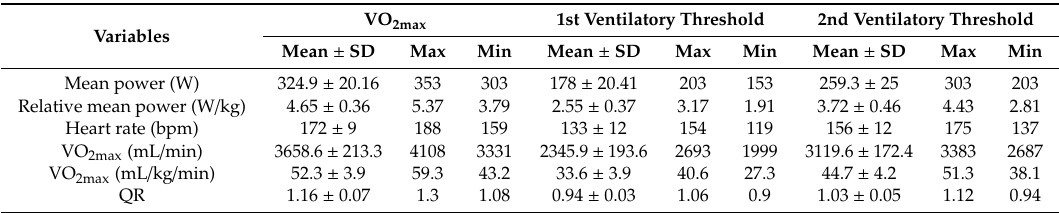
Table 1. Descriptive and statistical (minimum, maximum, mean and standard deviation (SD) values) values of the analyzed variables in the incremental maximal continuous